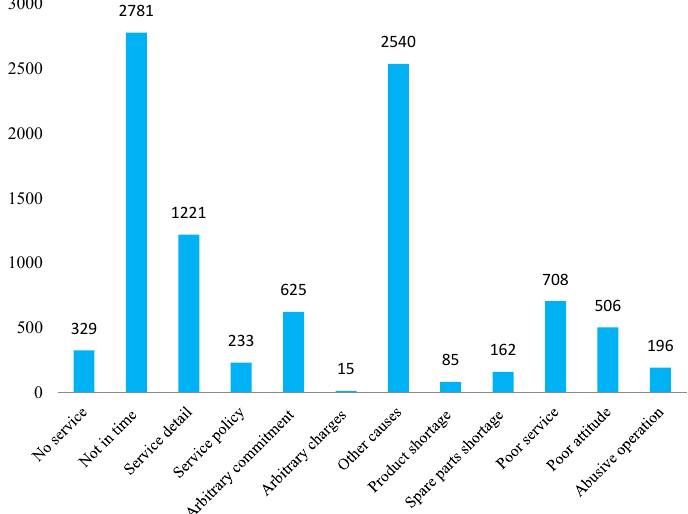
Appl. Sci. 2019 , 9 , 3313 Figure 4. Number of cases with di ff erent complaint causes. Figure 4. Number of cases with different complaint causes.